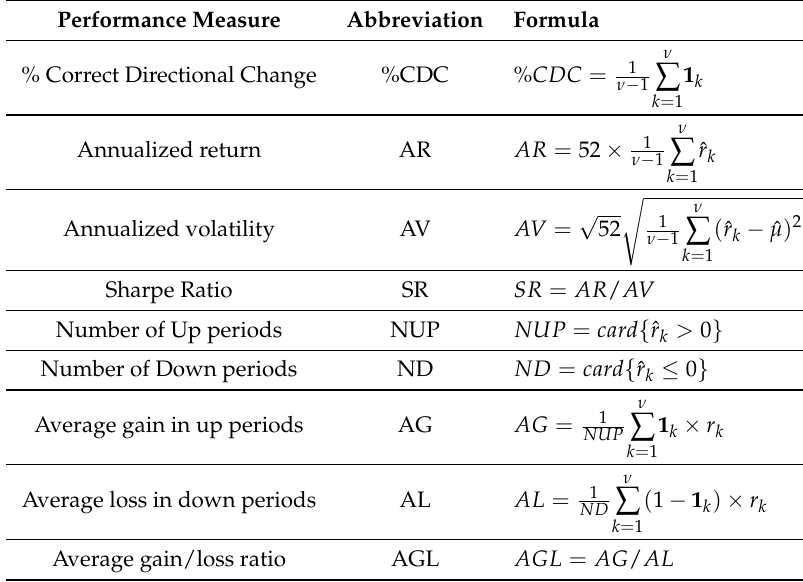
Table 8. Indicators employed to evaluate the performance of the trading